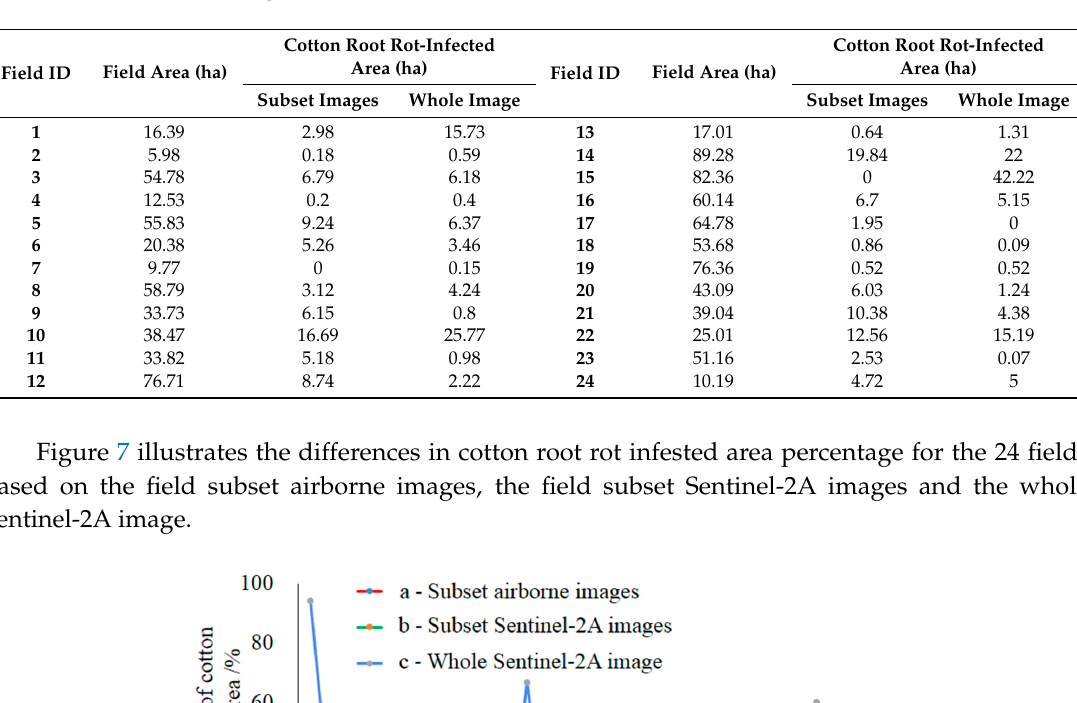
subset Sentinel-2A images for 24 cotton fields.